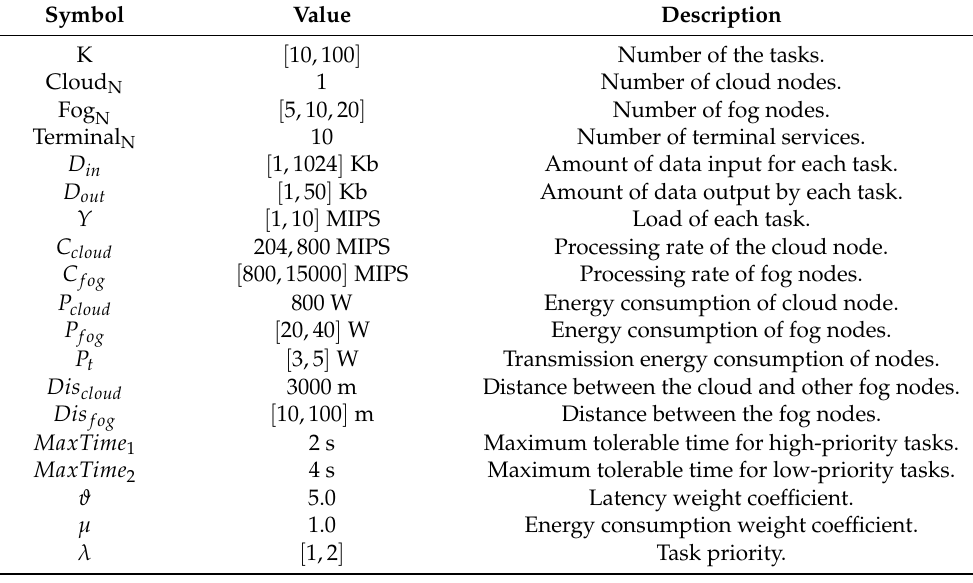
Table 1. Simulation parameters.